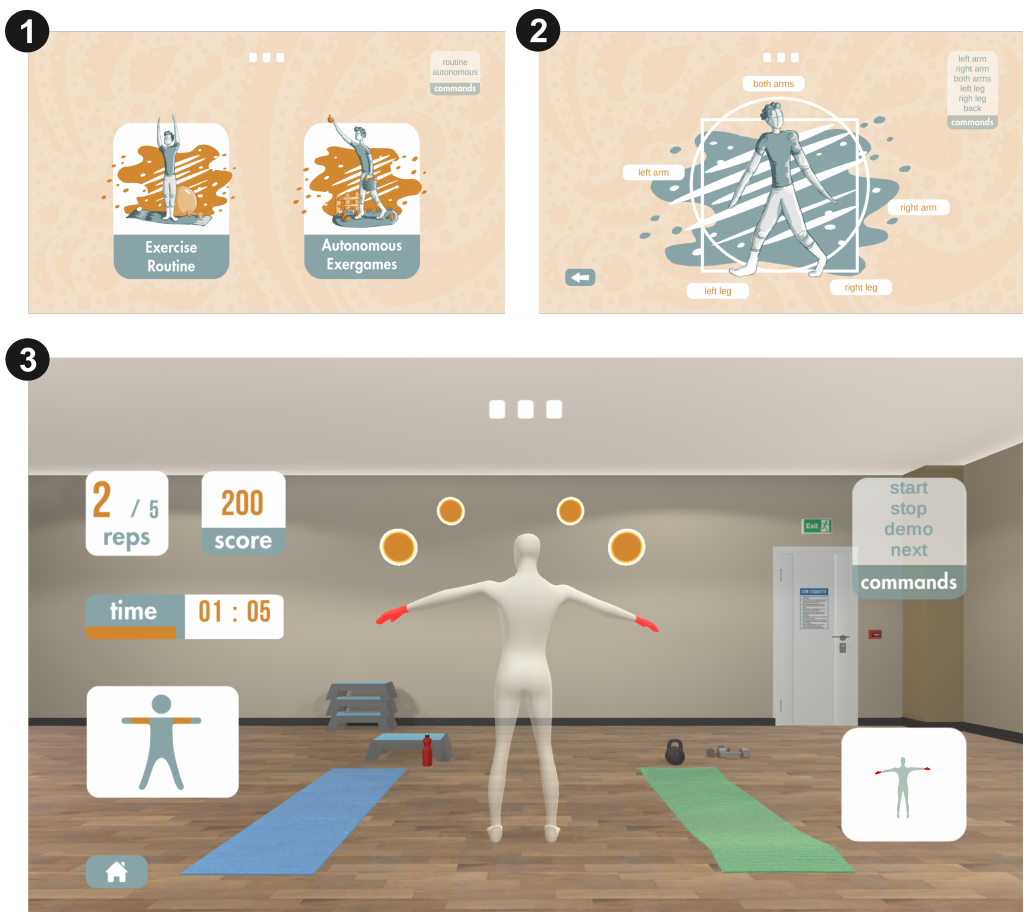
Figure 2. Graphical user interface of the prototype: (1) view for selecting the game mode; (2) view for selecting exergames depending on the involved joint/s; (3) view of one of the exercises that can be performed thanks to the proposed software prototype for home